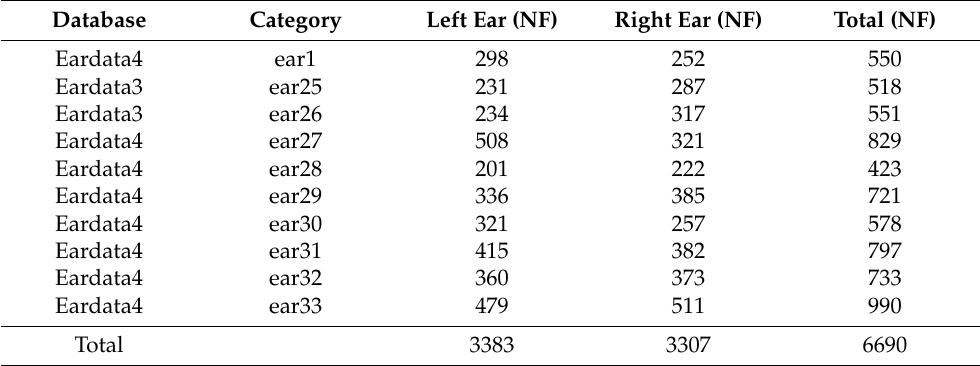
Table 12. The test video selection and frame